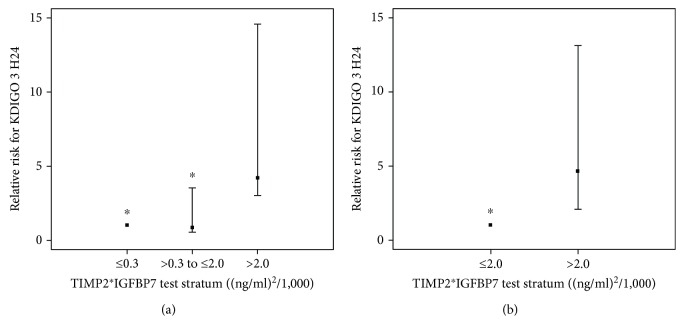
Relative risk of acute kidney injury (AKI) KDIGO 3 level within 24 hours (KDIGO 3 H24) in TIMP2∗IGFBP7 strata. (a) KDIGO 3 H24 risk in the stratum with TIMP2∗IGFBP7 values that are between 0.3 and 2.0 and greater than 2.0 relative to the values less than or equal to 0.3, and (b) KDIGO 3 H24 risk in the stratum with TIMP2∗IGFBP7 values that are greater than 2.0 relative to the values less than or equal to 2.0. Error bars are 95% confidence interval. ∗p < 0.05 versus >2.0.